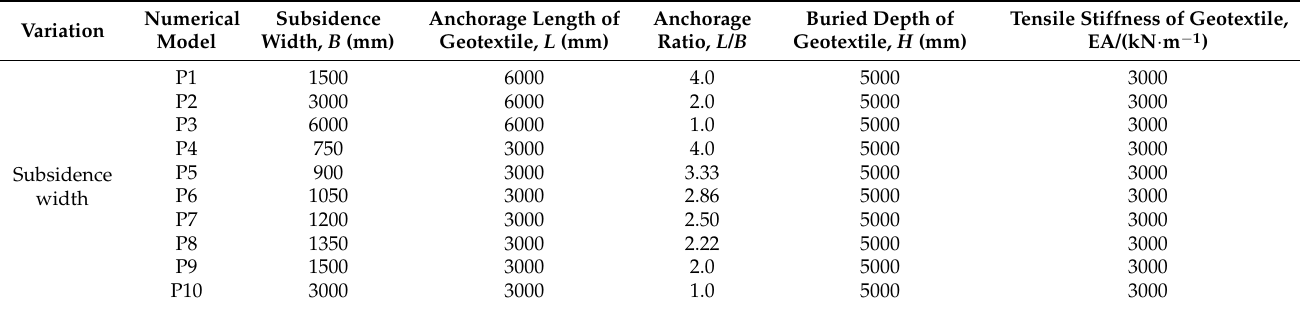
Table 4. Numerical models with various anchorage